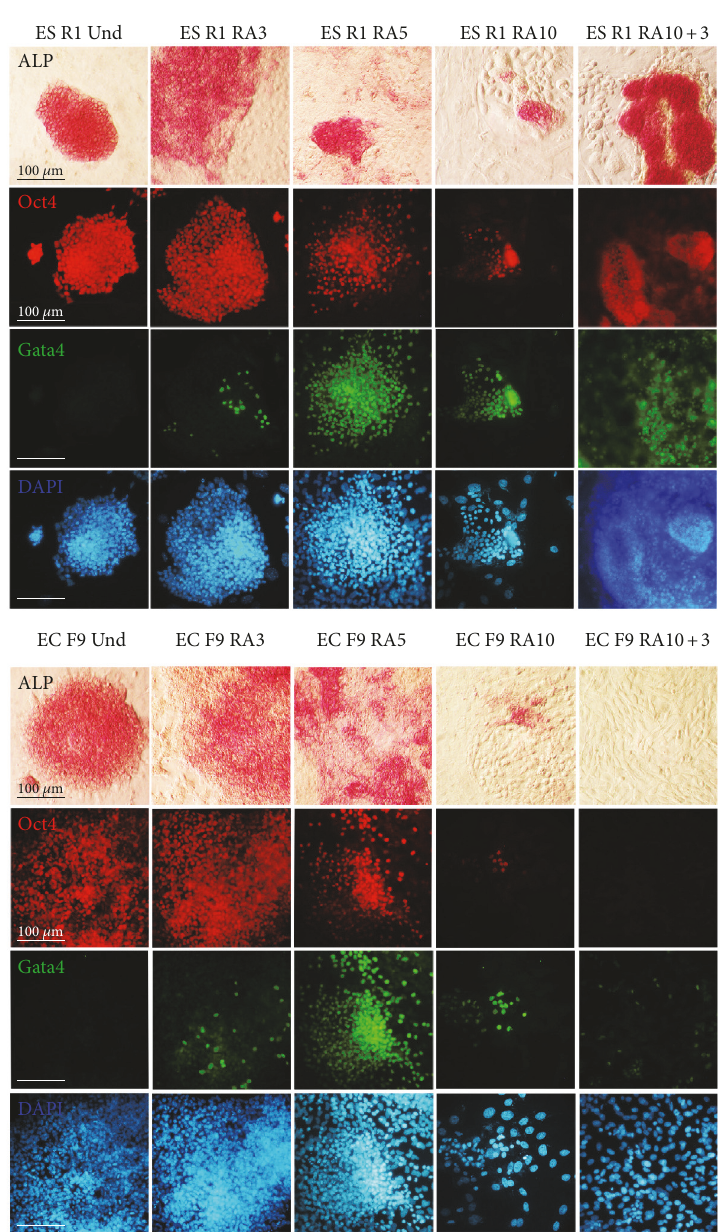
Figure 3: ALP activity and expression of Oct4 and Gata4 in di ff erentiating ES R1 and EC F9 cells after RA stimulation for 10 days and 3 days after RA withdrawal. Nuclei were counterstained with DAPI. A signi fi cant number of the ES R1 and EC F9 cells expressed both Gata4 and Oct4 at all stages of RA-stimulated di ff erentiation. Scale bar =100 μ